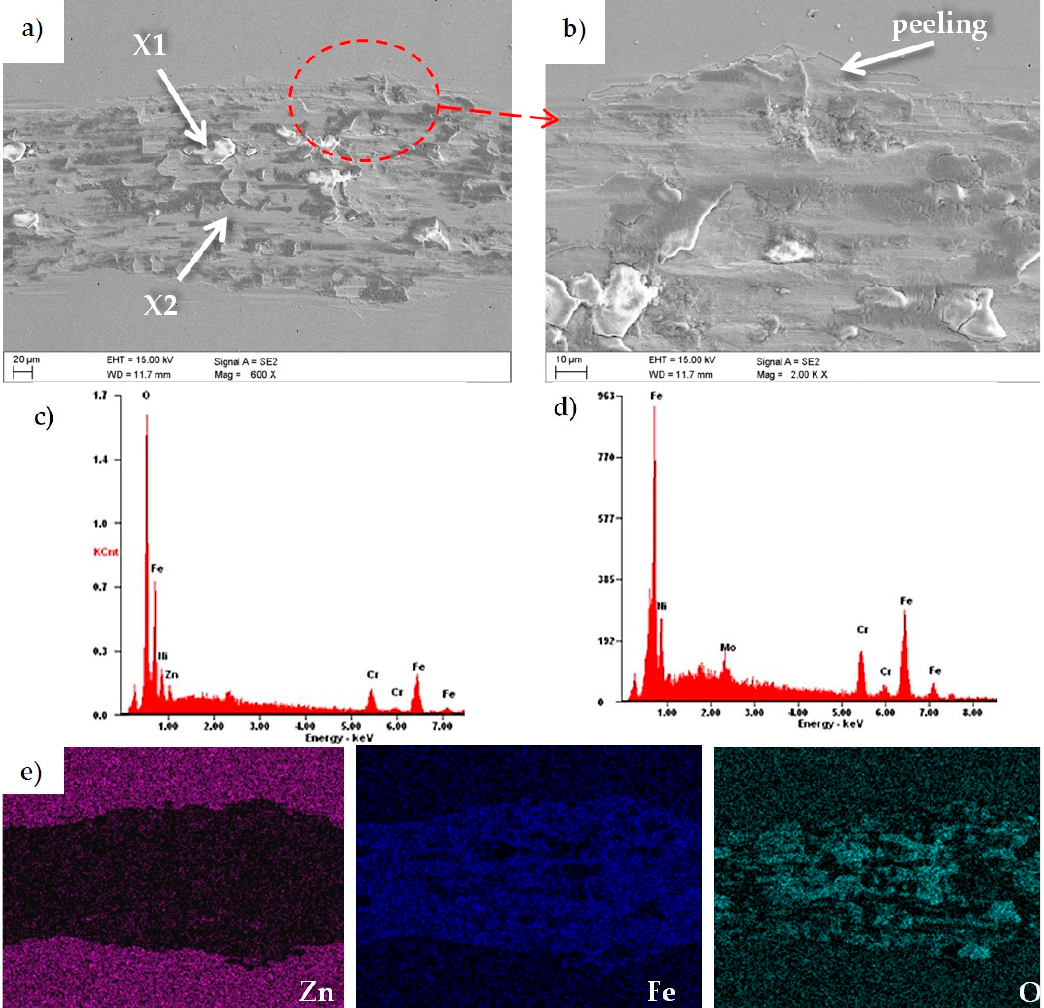
Figure 15. ( a , b ) Wear trace after the “ball-on-plate” wear test for the ZnO layer deposited in 1500 cycles, ( c ) X-ray energy dispersive plot of the area X1 shown in Figure 15a, ( d ) X-ray energy dispersive plot of the area X2 shown in figure, and ( b , e ) maps of superficial distribution chemical elements from the area shown in Figure 15a.